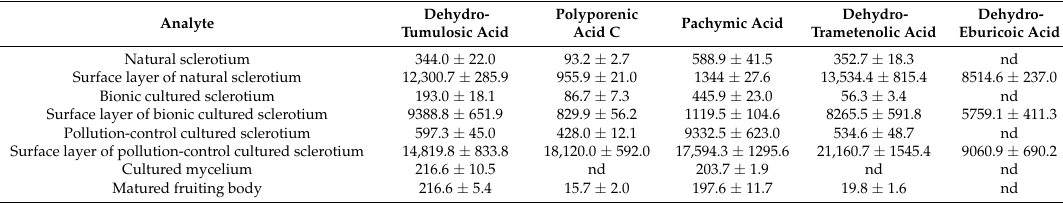
Table 3. Contents (mg/kg) of five triterpenoids in different tissues of W. cocos.